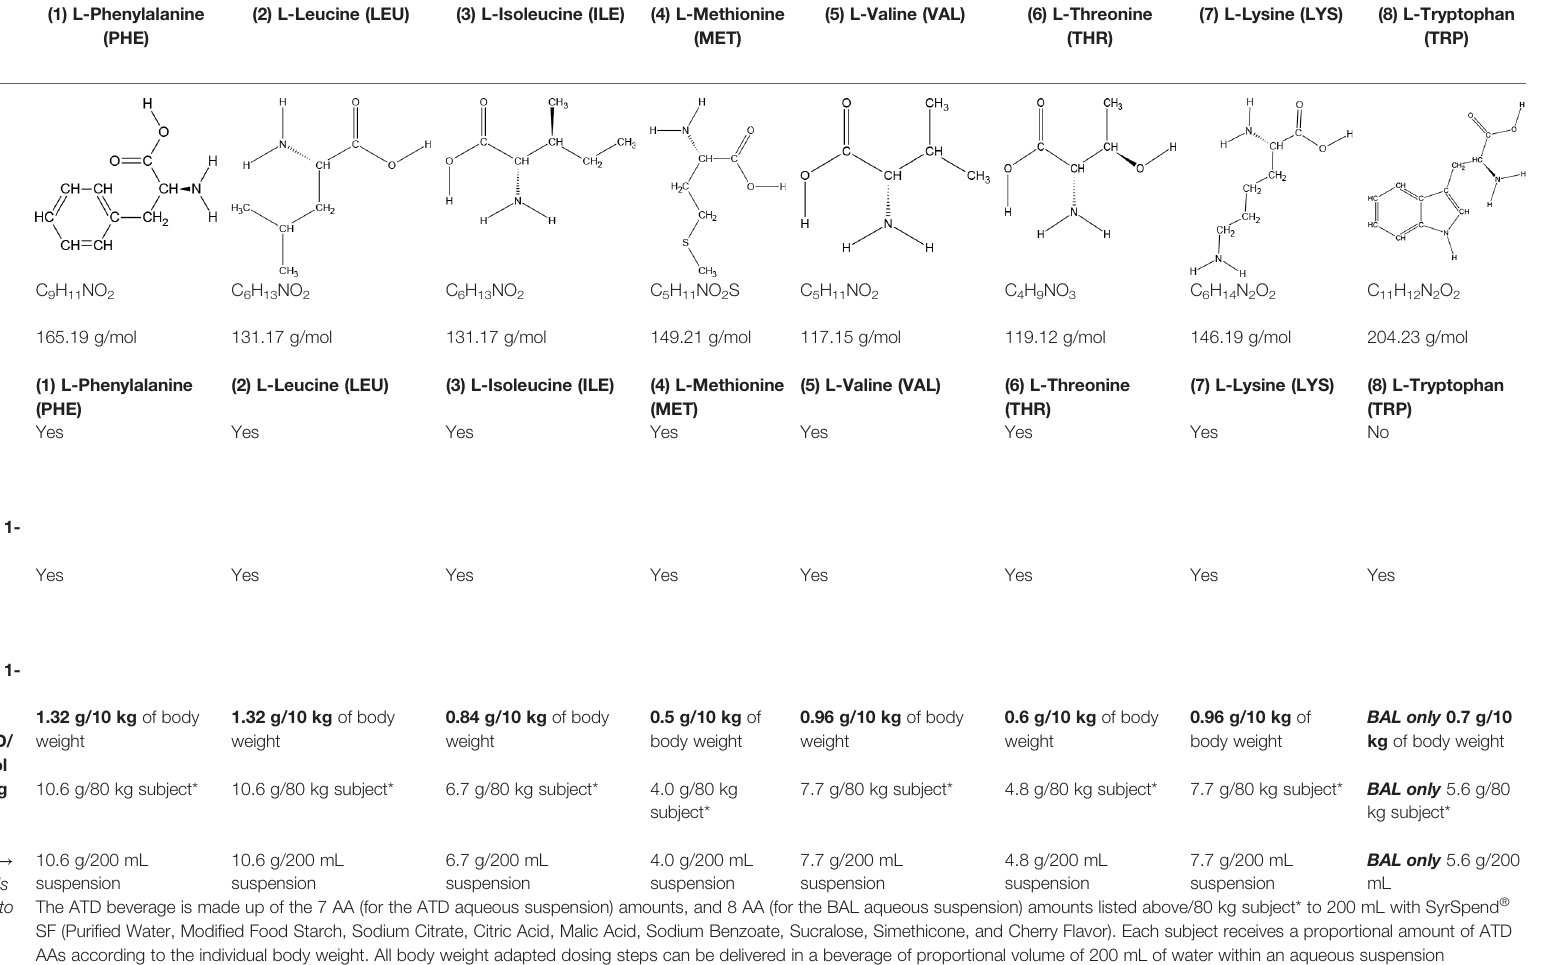
TABLE 1 | Chemical properties and descriptions of the AAs and amounts (grams/10kg body weight) that make up the ATD Moja-De and BAL mixture and a brief description regarding manufacturing, packaging and storage details for the AA. Amino acid